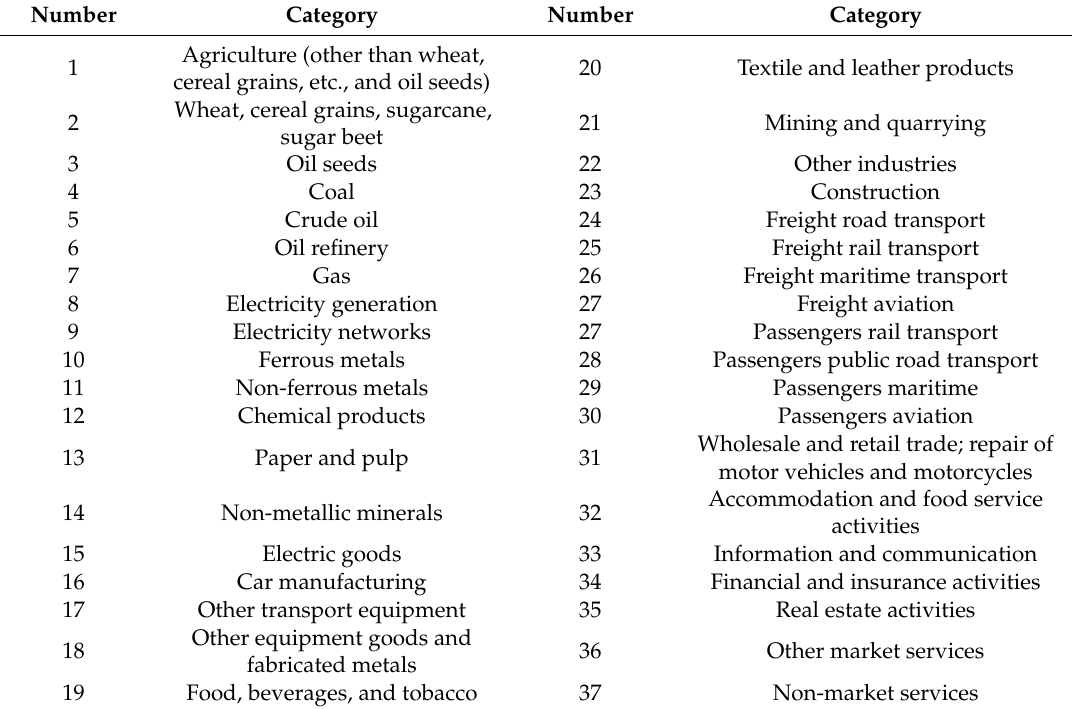
Table 2. Sectoral coverage of the GEM-E3-R